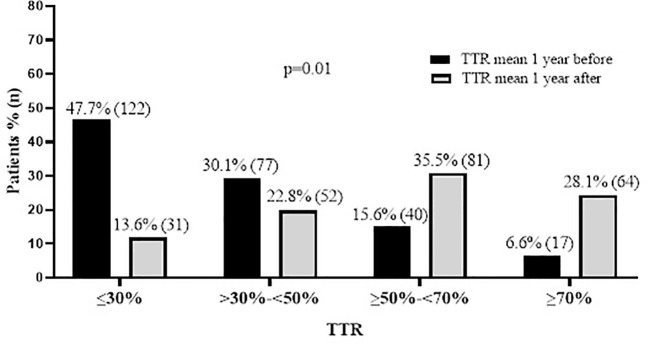
Comparison of percentages of patients that had Time in the Therapeutic Range (TTR)≤30%, TTR>30% - <50%, TTR ≥50%-<70%, and TTR ≥70% in different periods (1 year before and 1 year after pharmaceutical care). Data are presented as % (and absolute number of patients).